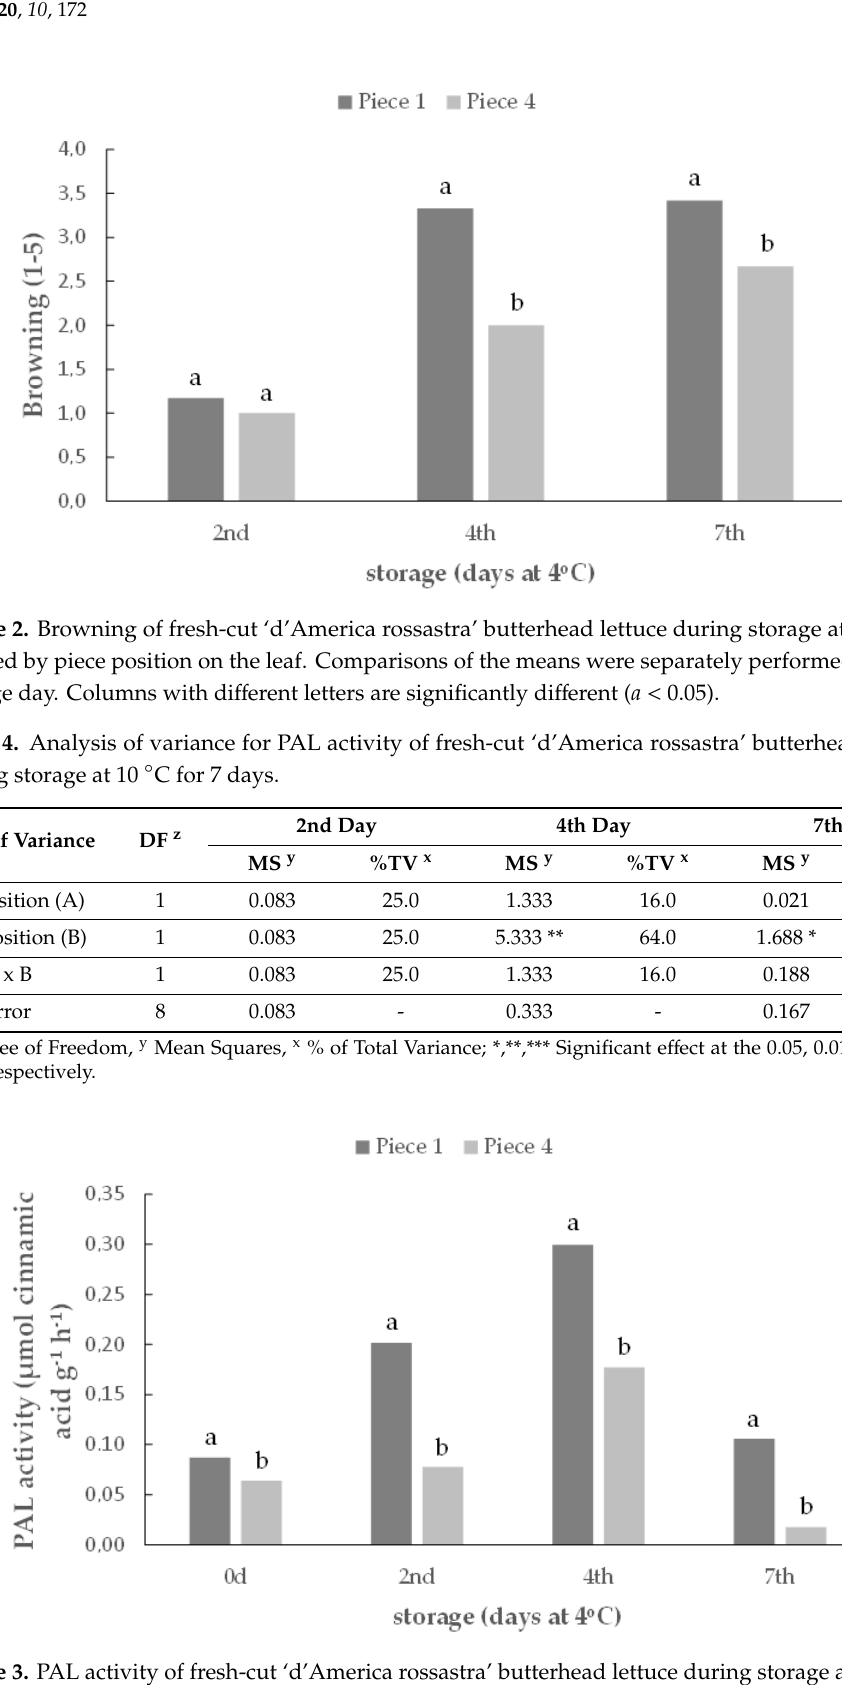
Figure 3. PAL activity of fresh-cut ‘d’America rossastra’ butterhead lettuce during storage at 10 °C as affected by piece position on the leaf. Comparisons of the means were separately performed for each storage day. Columns with different letters are significantly different ( a < 0.05).